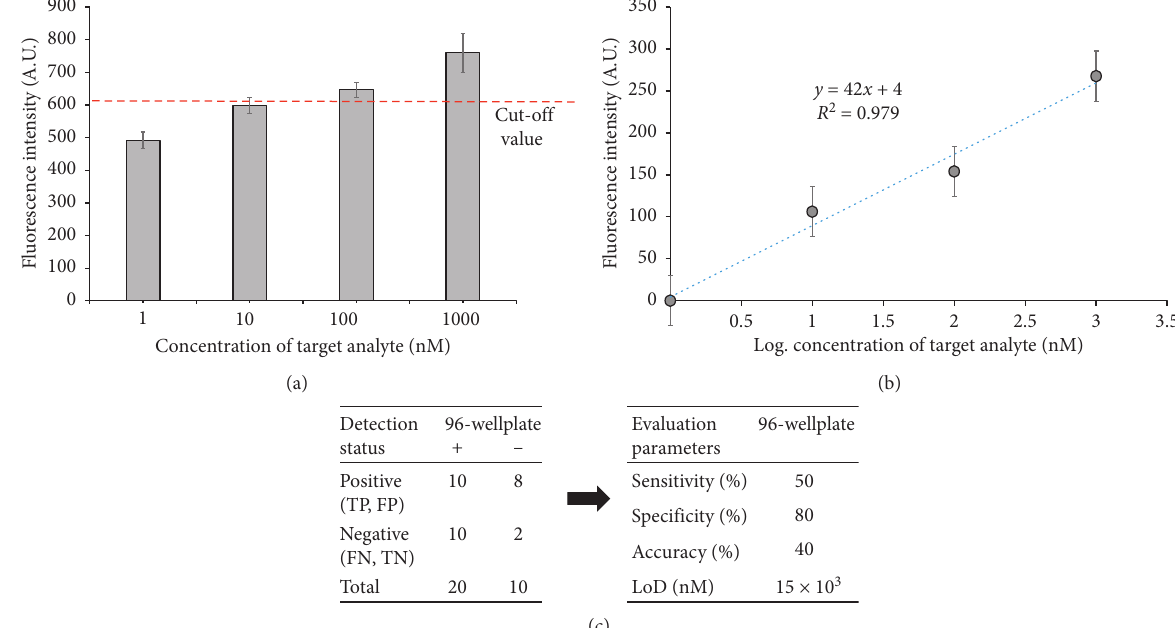
Figure 5: Performance evaluation of conventional 96-well plates: (a) performance analysis of the conventional well plate in miRNA detection (concentration of the labeled miRNA � 1nM); (b) ELISA calibration curve plotted for varied concentrations of the labeled miRNA (1nM, 10nM, 100nM, and 1000nM); (c) evaluation of the assay and calculated analytical sensitivity, specificity, accuracy, and